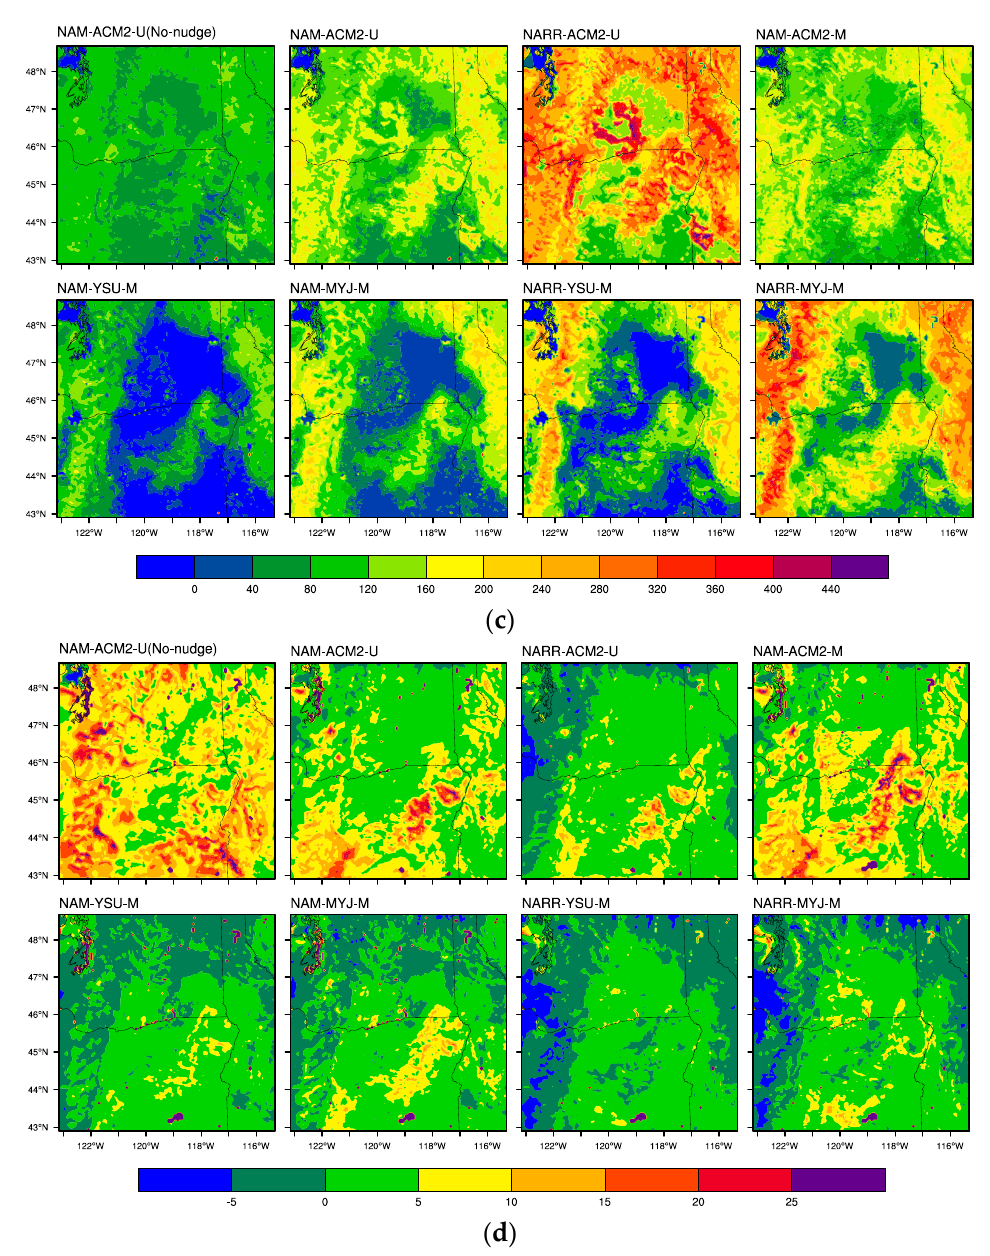
Figure 4. Averaged simulated ( a ) daytime sensible heat flux, ( b ) nighttime sensible heat flux, ( c ) daytime latent heat flux, and ( d ) nighttime latent heat flux in the second domain (4.5 km resolution) from the eight different WRF scenarios over the observation time period.